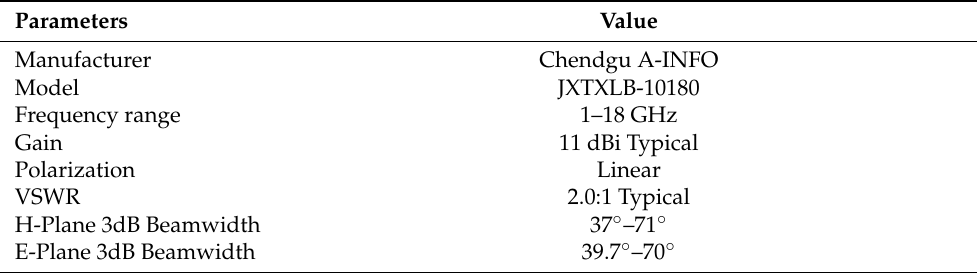
Figure 3. Wide-band horn antenna. Table 4. Wide-band Horn Antenna Parameters.